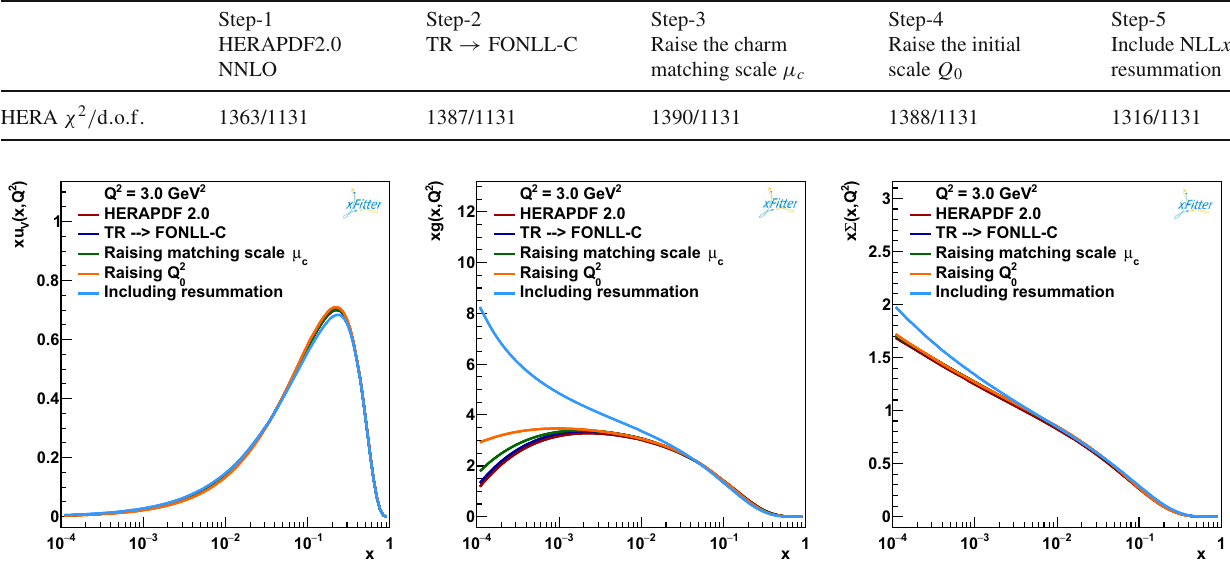
Fig. 1 The up valence PDF xu v , the gluon PDF xg and the total singlet PDF x Σ for each of the 5 steps outlined in the